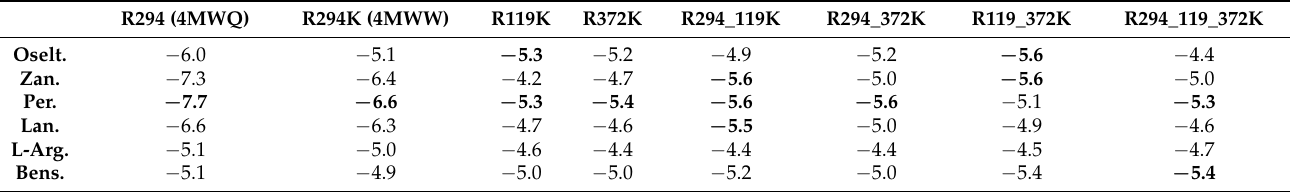
Table 3. The S scores according to MOE software 1